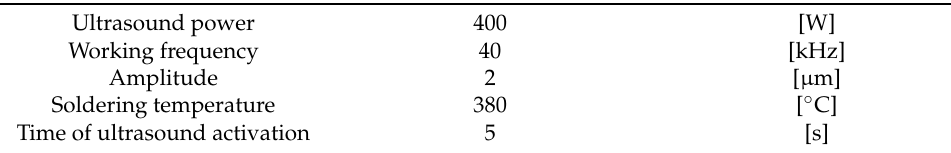
Figure 3. Schematic representation of ultrasonic activation on the substrate surface. Table 2. Soldering parameters.